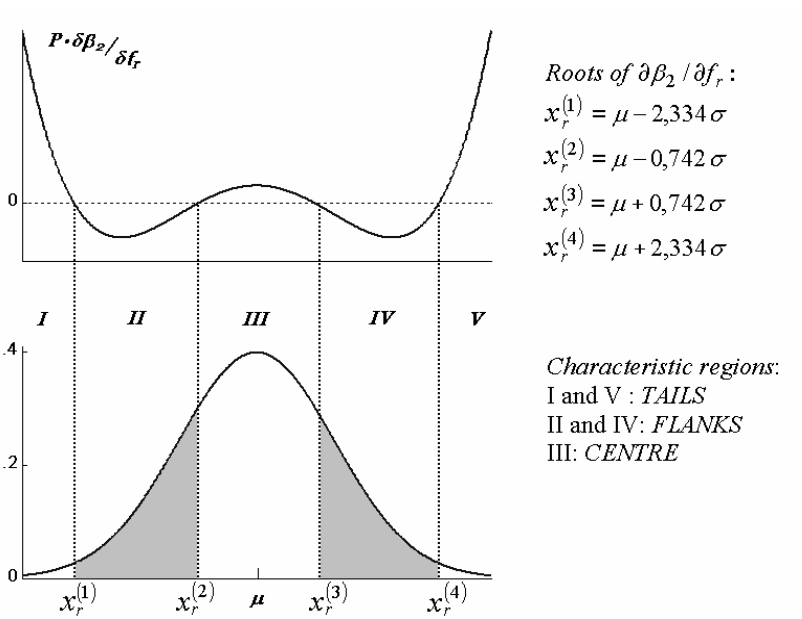
(cid:32) 3 (top), with indication of the ranges cor- 2